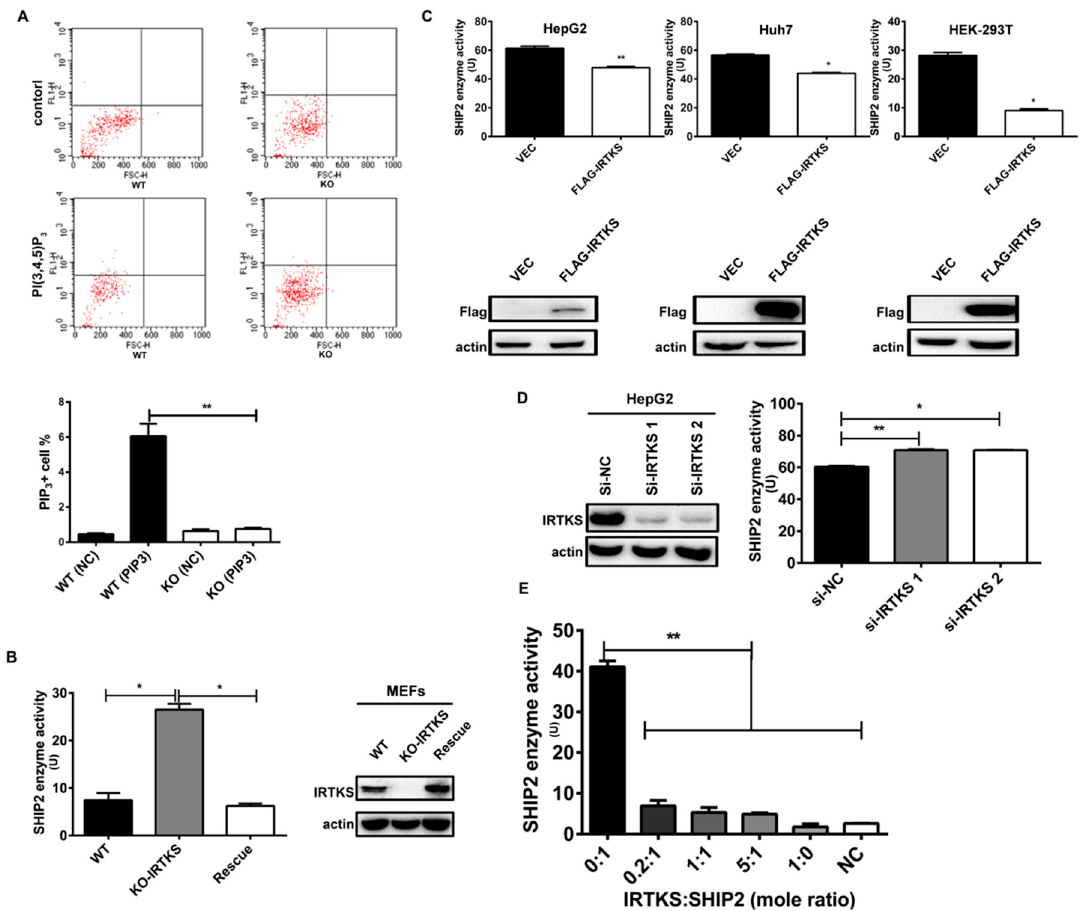
Figure 3. IRTKS suppresses SHIP2 phosphatase activity. ( A ) The PI(3,4,5)P 3 in WT and IRTKS KO MEFs stimulated by insulin for 15 min was labeled by anti-PI(3,4,5)P 3 antibody and assessed by a flow cytometer. Control cells were incubated with bovine serum albumin (BSA); ( B ) The SHIP2 activity was significantly increased in IRTKS KO MEFs, while the ectopic IRTKS rescue decreased SHIP2 activity. Here SHIP2 proteins immunoprecipitated with anti-SHIP2 antibody in WT, IRTKS KO, and the IRTKS-rescued MEFs were used to determine its phosphatase activity via malachite green phosphatase assay; ( C ) Over-expression of IRTKS attenuated SHIP2 phosphatase activity in HepG2, Huh7, and HEK293T cells; ( D ) Knocking down IRTKS promoted SHIP2 phosphatase activity in HepG2 cells. ( E ) The IRTKS/SHIP2 ratio affected SHIP2 phosphatase activity. Different amounts of Flag–IRTKS and Flag–SHIP2 proteins purified from HEK293T cells were added in the malachite green phosphatase assay. Fluorescence Activated Cell Sorter (FACS) assay and phosphatase assay were performed in triplicates. The data are shown as mean ± SD. * p < 0.05, ** p < 0.01 (Student’s t -test).